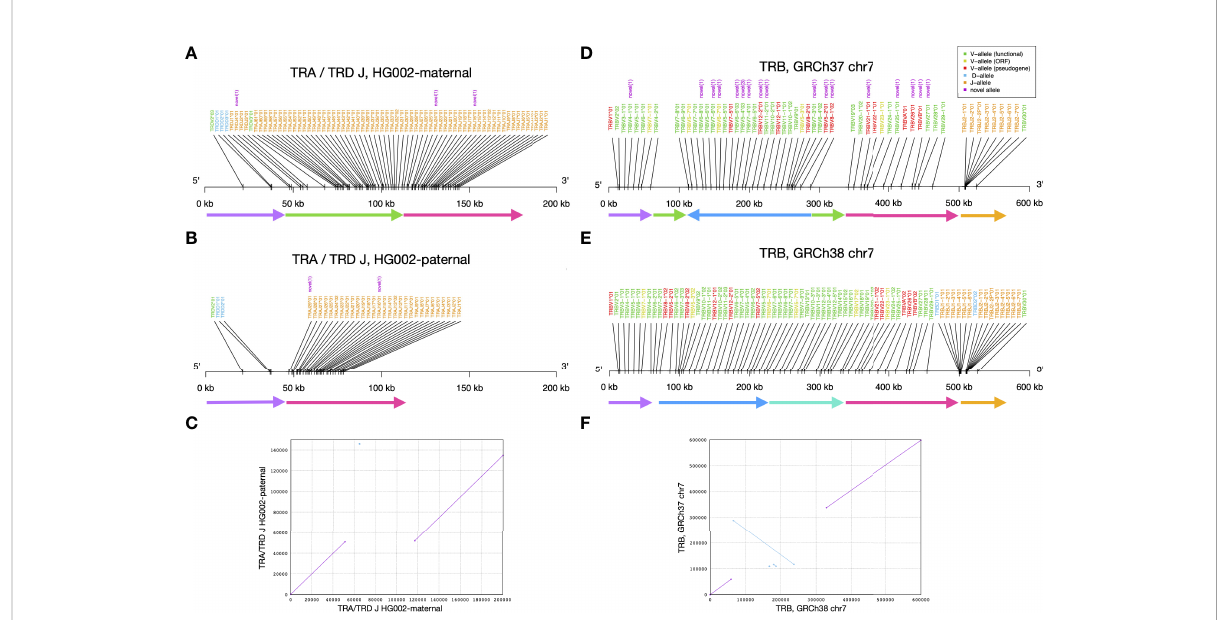
FIGURE 5 Structural variants identi fi ed by gAIRR-annotate. (A – C) The 65 kbp structural variation in TRA and TRD J region of HG002. (A) The maternal haplotype, (B) the paternal haplotype, and (C) the sequence alignment of HG002 ’ s maternal and paternal TRA/TRD J sequence. In (A, B) the arrows with the same color can be aligned between the two haplotypes. The green arrow is the segment deleted in paternal haplotype. (D – F) The inversion and deletion of TR beta chain germline genes of the reference genome. (D) GRCh37 chr7, (E) GRCh38 chr7, and (F) the sequence alignment of GRCh37 and GRCh38 at TR beta chain. In (D, E) , the arrows with the same color can be aligned between the two haplotypes. The deep blue arrow indicates the inversion between the reference genomes.